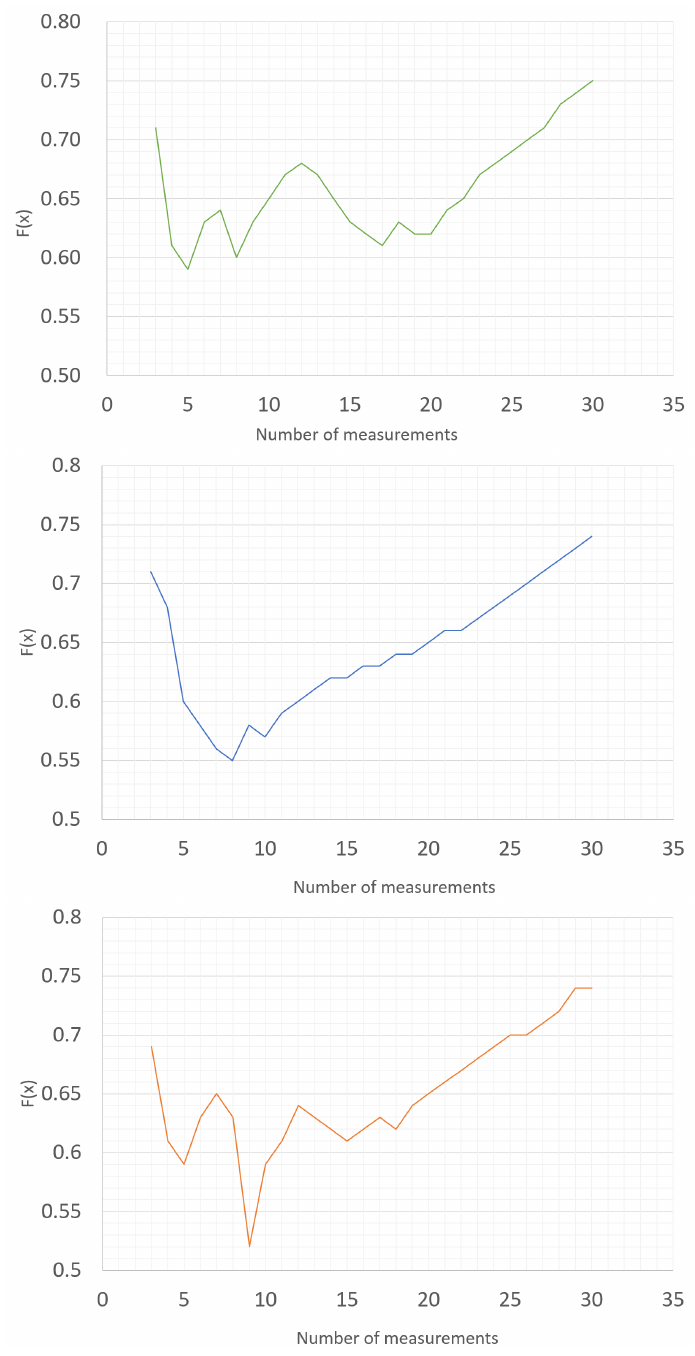
Figure 3. Optimal solutions in the weighted objectives method for different sets of input